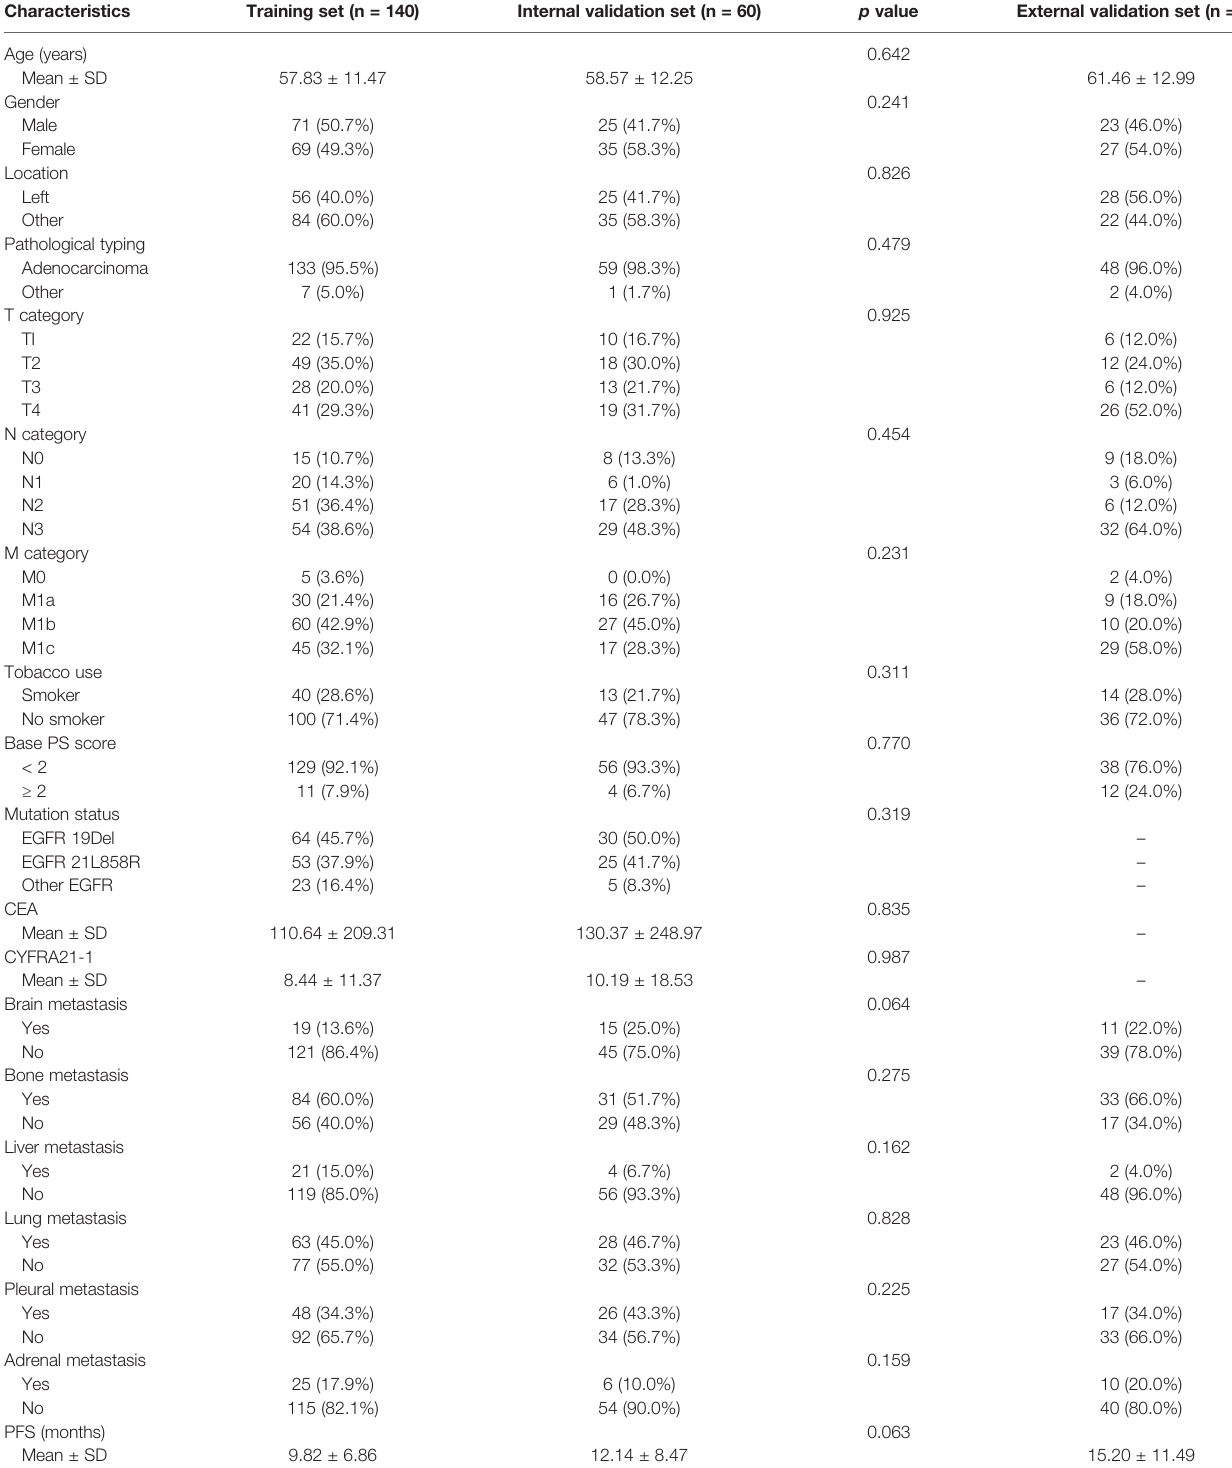
TABLE 1 | Demographic and clinicopathologic characteristics of the training cohort, internal validation cohort and external validation cohort.